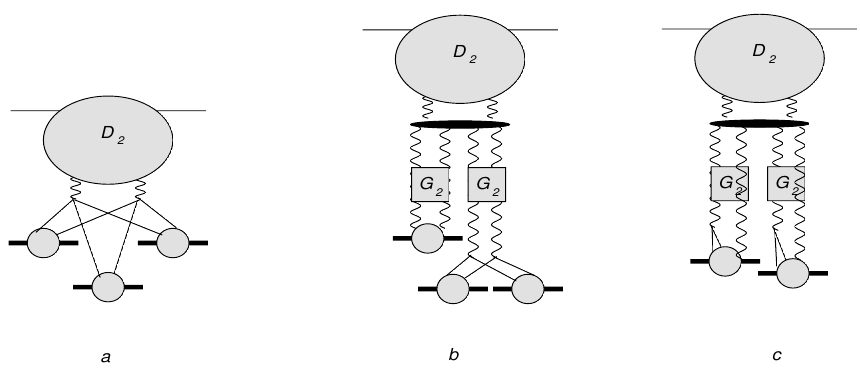
Figure 12 . Reggeized terms in D 6 : (a) a term in D R in D I ; R ( L )